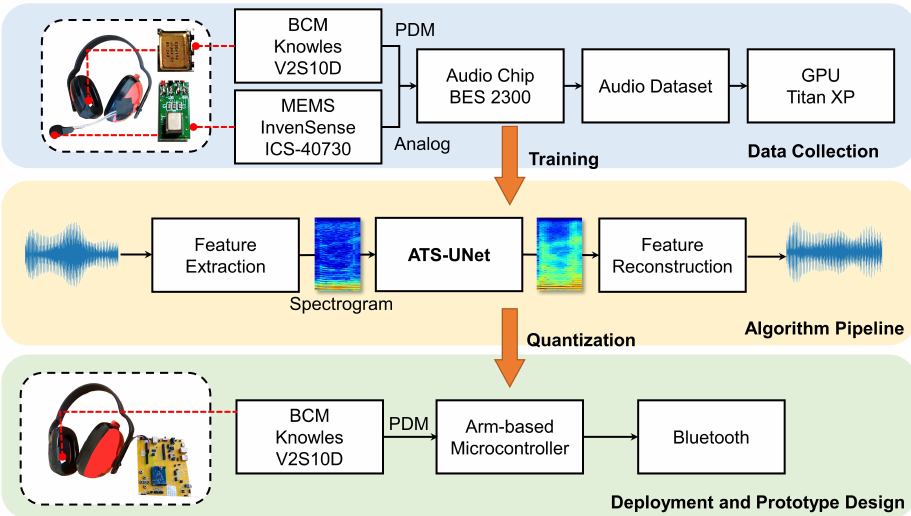
Figure 1. This paper’s